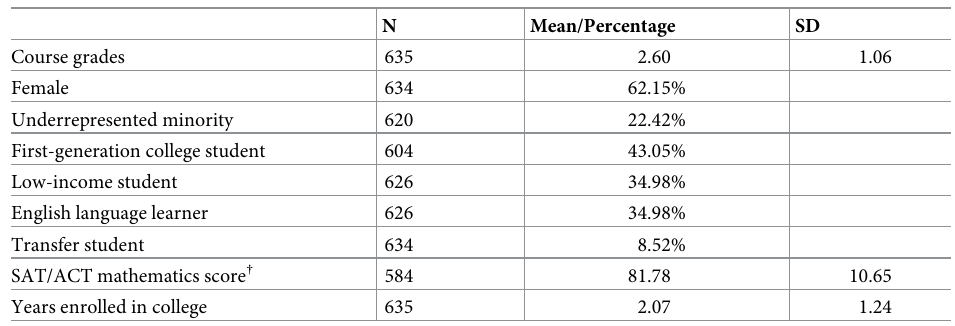
Table 2. Descriptive information.